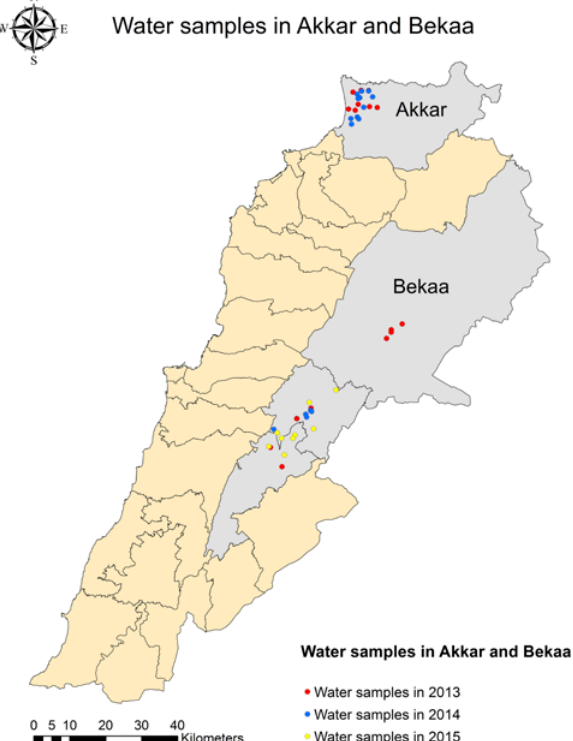
Figure 1. Potato sampling sites in the Akkar district and the Bekaa valley in Lebanon, during three growing seasons.